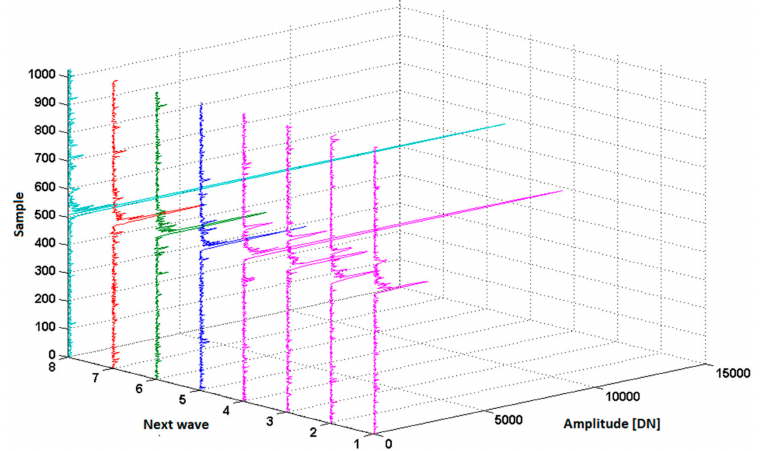
Figure 4. Visualization of the 3D data registered in a sequence: waves in pink colour contain the registration of two echoes, other waves are registration of one